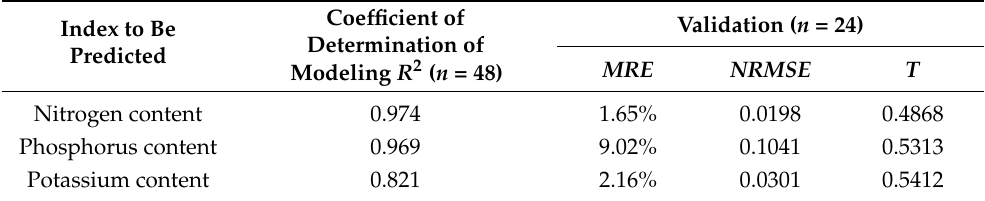
Table 5. Results of neural network diagnosis model based on binary wavelet sensitivity coefficient for sweet corn nitrogen, phosphorus and potassium